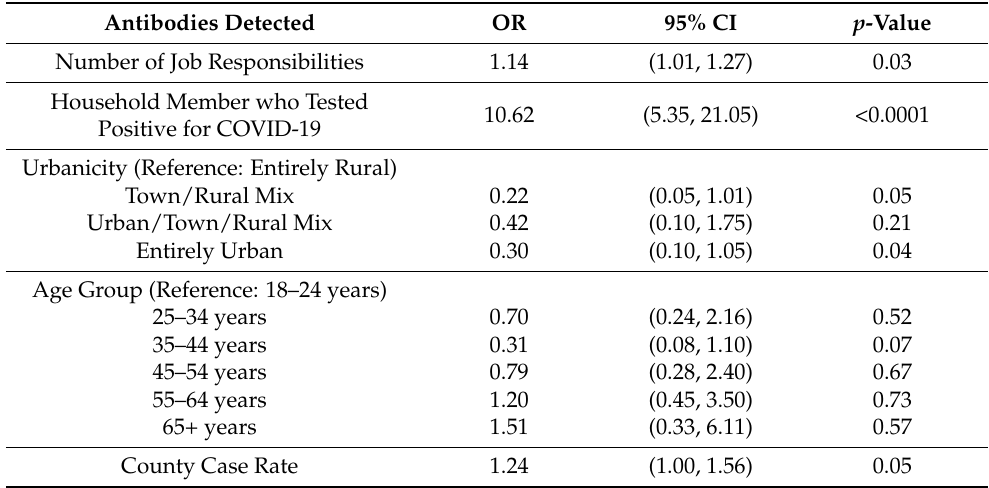
Table 2. Logistic regression analysis of the number of job responsibilities and seropositivity adjusted for urbanicity, age group, and county case